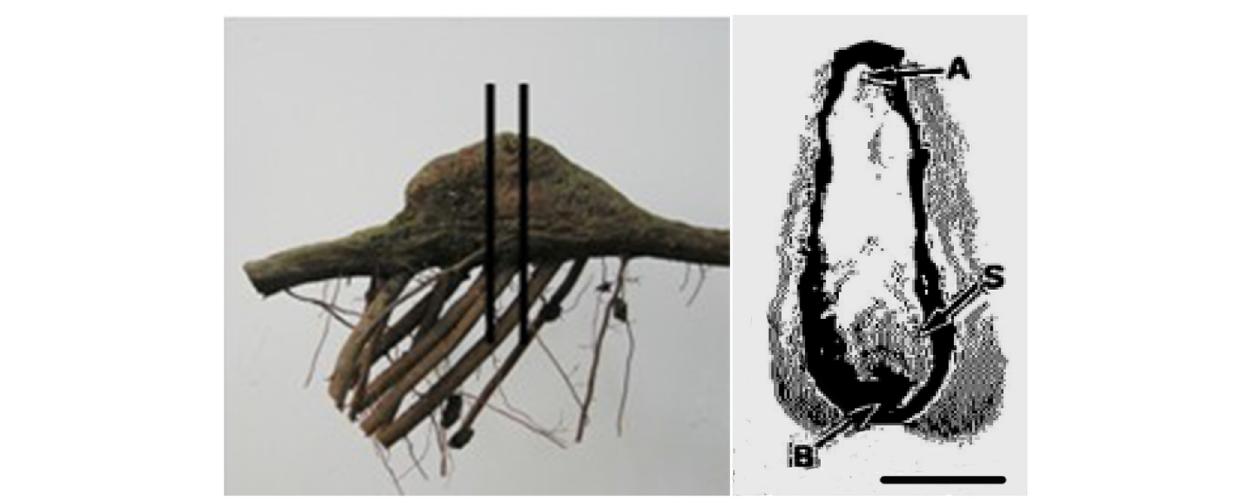
FIGURE 3 | Photographs of a root segment with a knee root (left) and transverse section of a knee root (right) . Vertical bars indicate the portion with the transverse section of the knee root. Letters indicate positions of samples for microscopic observations. The horizontal bar equals 2 cm. A, apex; B, base; S, side.